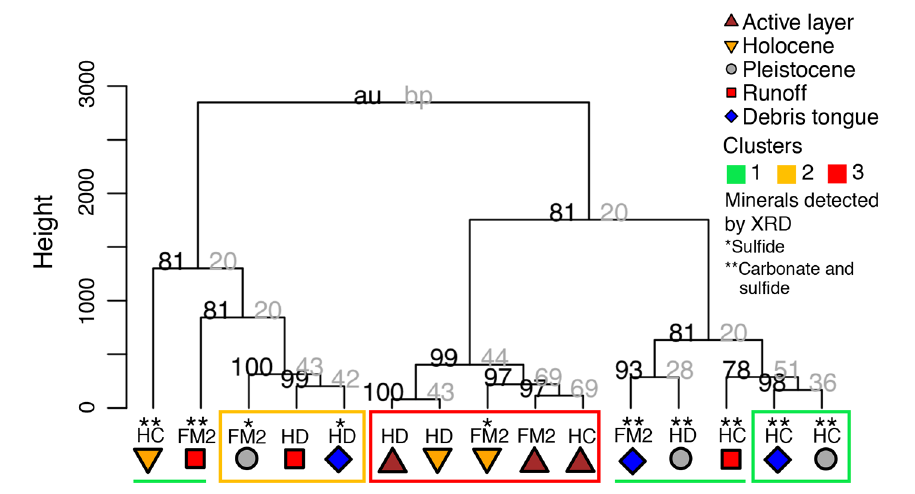
FIGURE A1 | Geochemical clusters from the pvclust analysis. Rectangles denote clusters where p < 0.05. au, approximately unbiased p -value; bp, bootstrapped probability.